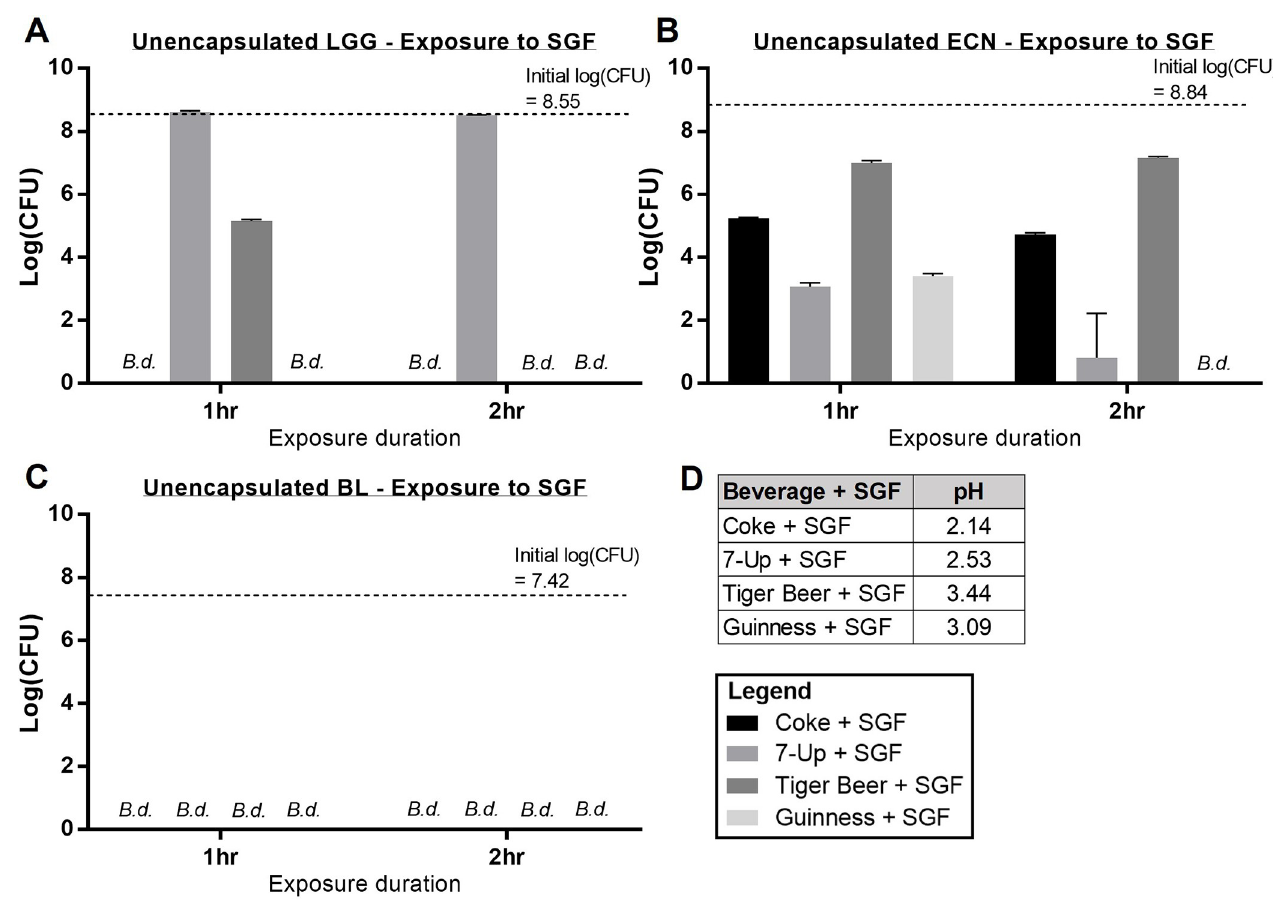
Fig 2. LogCFU survival of unencapsulated probiotics in various SGF and beverage combinations. (a) Unencapsulated LGG survival, (b) unencapsulated ECN survival, (c) unencapsulated BL survival; (d) pH values of various SGF and beverages combinations at room temperature. B.d. indicates cell count was below detection limit of ~1.5